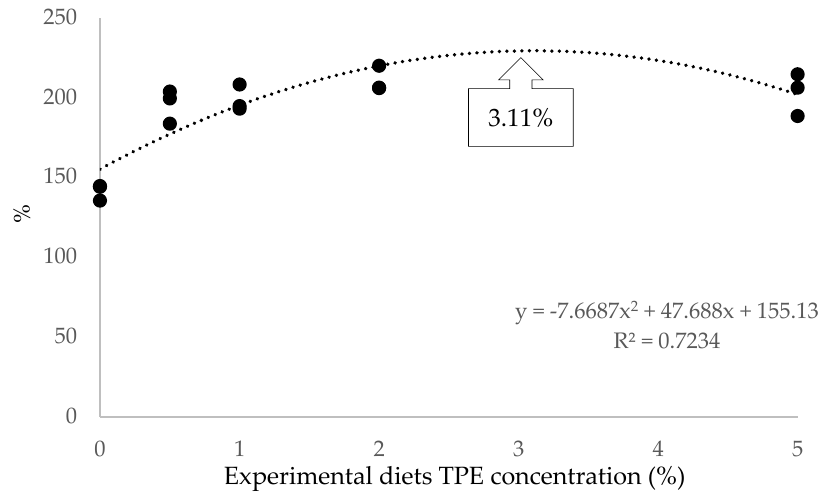
Figure 1. The relationships between dietary tomato paste by-product extract (TPE) concentrations and relative growth rate (RGR) (%) of Cyprinus carpio. Table 4. Hematological parameters of common carp fed with experimental diets supplemented with different ratios of tomato paste by-product extract